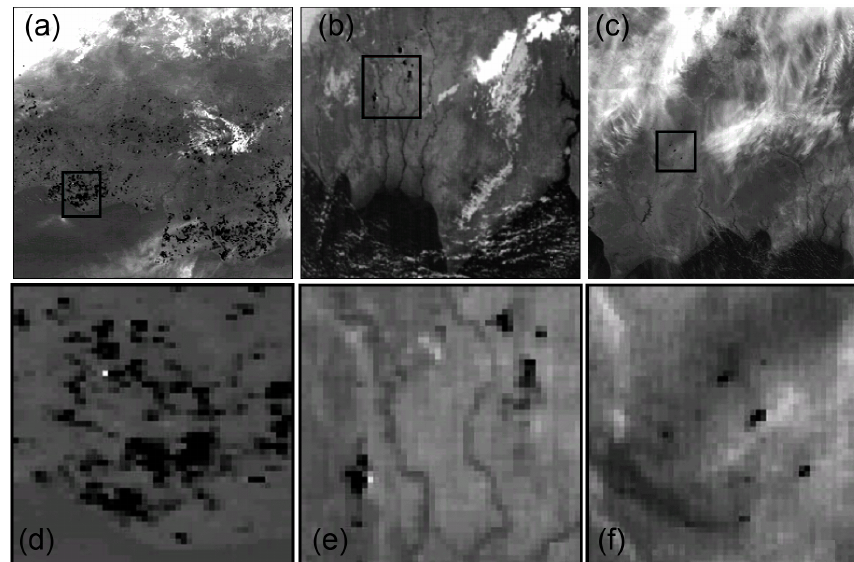
Fig. 2. Raw night-time AVHRR Local Area Coverage (LAC: 1.1km spatial resolution at nadir) imagery of the coast of Central Kalimantan. Data shown are image subsets from the AVHRR 3.7µm channel, with boxed areas shown magnified beneath. Data were collected during (a) El Ni˜no (21 October 1997), (b) “normal” (6 September 2001) and (c) La Ni˜na (29 July 1999) climatological episodes. Each top-row image covers an area of around 300 × 300km, and the Java Sea can be seen towards the bottom of each image subset. The AVHRR 3.7µm channel is highly sensitive to active fires, with increased pixel radiances resulting even from highly sub-pixel events (Robinson, 1991). Such fire affected pixels show elevated 3.7µm channel spectral radiances (due to the intense fire thermal emissions in this wavelength range), and appear black in this rendition. Meteorological clouds typically show low 3.7µm channel spectral radiances at night (due to their low temperatures), and appear white in this rendition. Active fire pixels can be seen in each scene, but their number decreases substantially when you move from “El Ni˜no” to “normal” and then to “non El Ni˜no” conditions. Different image dates are necessarily shown in each year to the relative scarcity of AVHRR LAC images over Borneo (see Sect. 3.1), but the selected images depict typical examples of the fire situation for each of the three climatological conditions. Data shown are raw AVHRR LAC imagery, uncalibrated and not geometrically